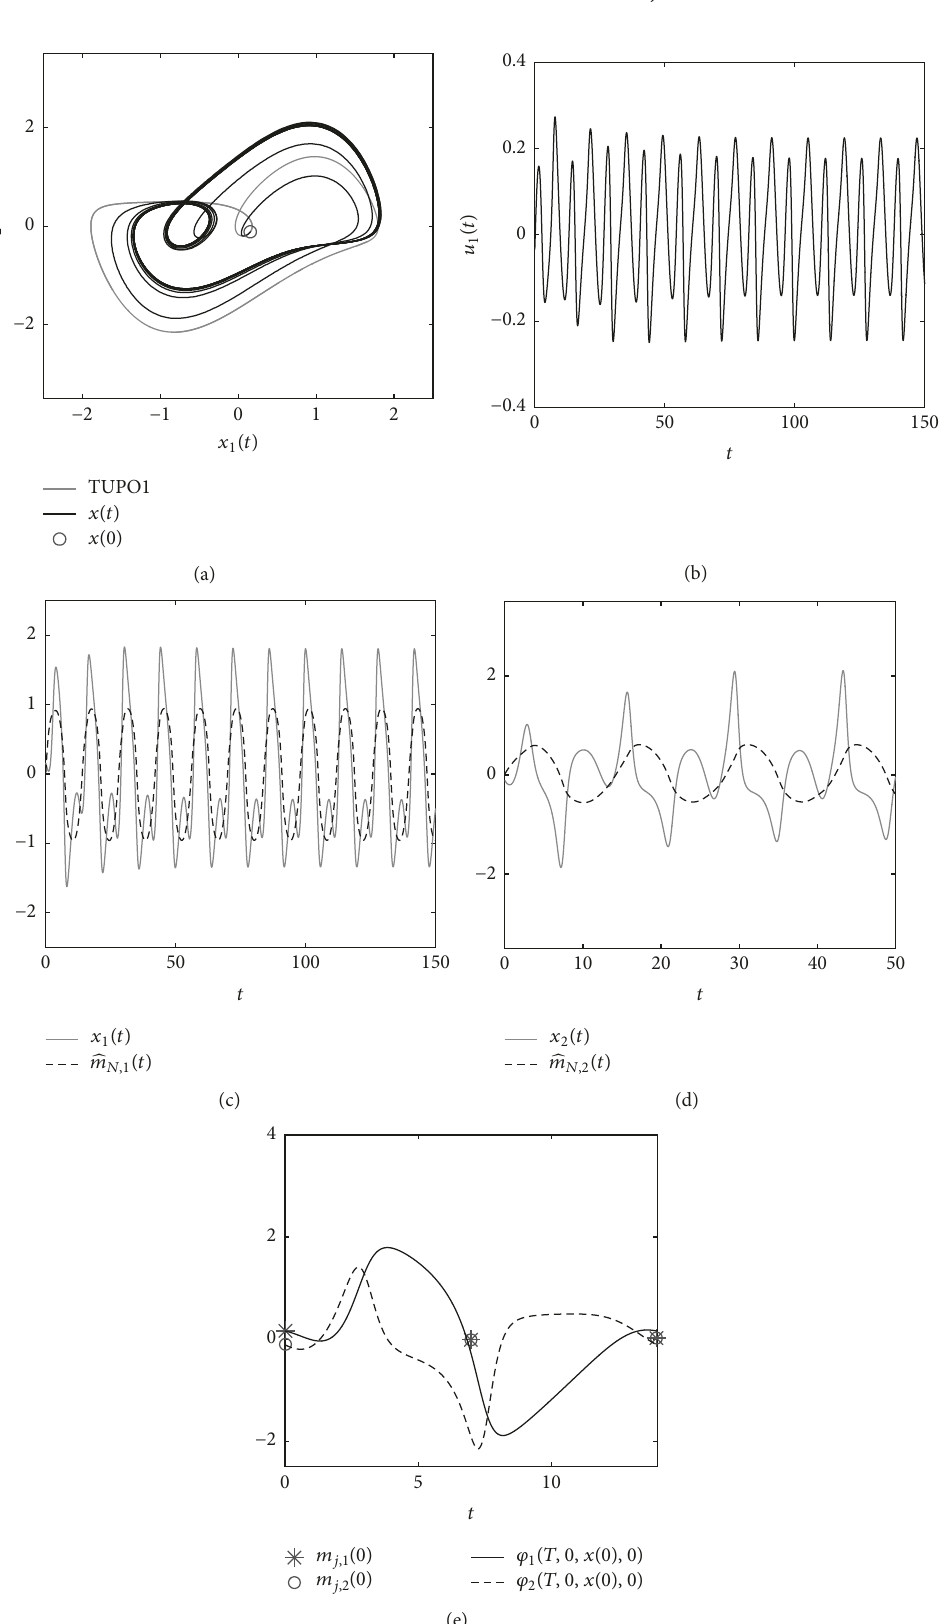
Figure 12: aPBC applied with 𝑁 = 3 , 𝑘 = 0.25 , and 𝑘 𝑜 = 10 . (a) Trajectory in state space; (b) time-series of the control signal; ((c) and (d)) time-series of the actual and predicted state variables; (e) time-series of 𝜑(𝑇,0, 𝑥(0),0) and the initial value of the predicted states 𝑚 𝑗 (0)